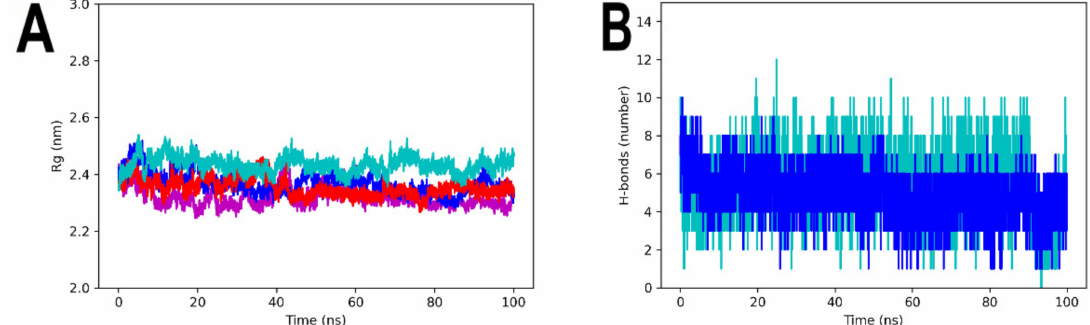
Figure 7. MDS analyses of apo-3ZKBL and 3ZKBL complexed to ANP, BS1, and ATD ( A ) Rg values. ( B ) Hydrogen bond number. The colors magenta, red, dark blue and light blue represent apo-3ZKBL, 3ZKBL-ANP, 3ZKBL-BS-1 and 3ZKBL-ATD, respectively. The analyses were performed with GROMACS.